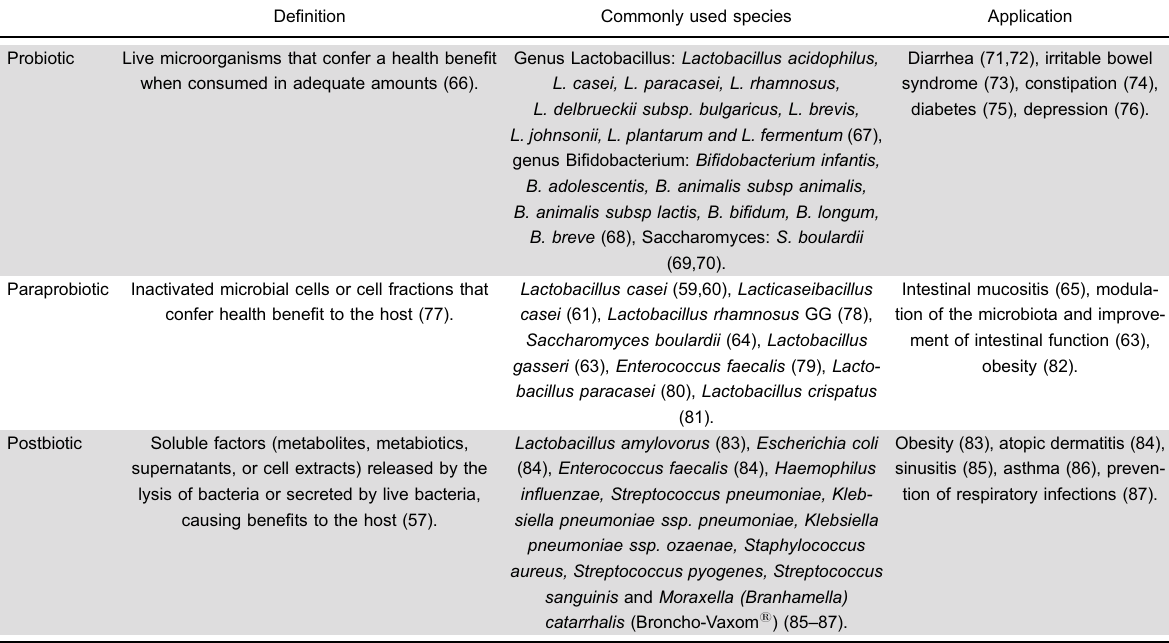
Table 1. Probiotic, paraprobiotic, and postbiotic de fi nitions and